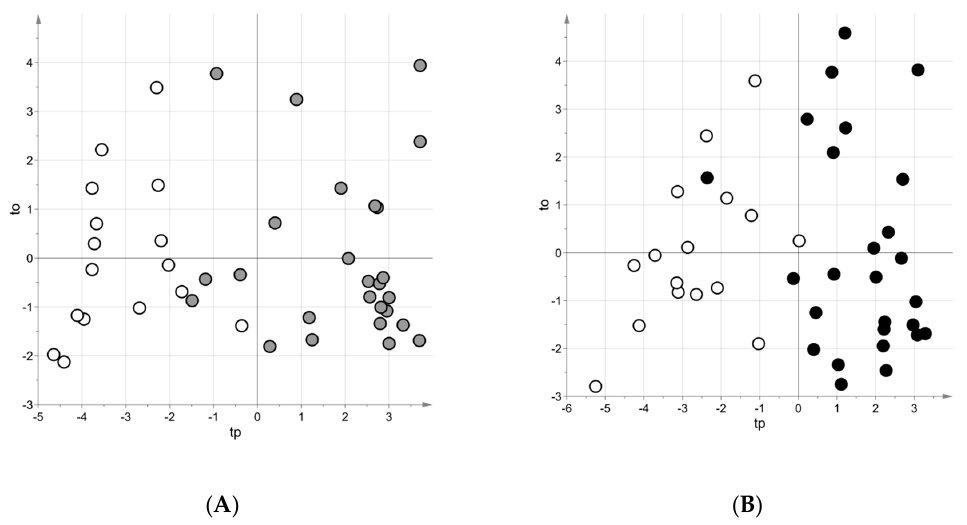
Figure 1. Score scatter plots of the projection to latent structures-regression-discriminant analysis (PLS-DA) models after post-transformation obtained for the data in negative-ionization mode. ( A ) Group T0 vs. controls (108 variables, A = 2 latent variables, MCC in 5-fold cross-validation = 0.76); ( B ) Group T1 vs. controls (108 variables, A = 2 latent variables, MCC in 5-fold cross-validation = 0.65). White circles—controls; gray circle—samples of Group T0; black circles—samples of Group T1 as.